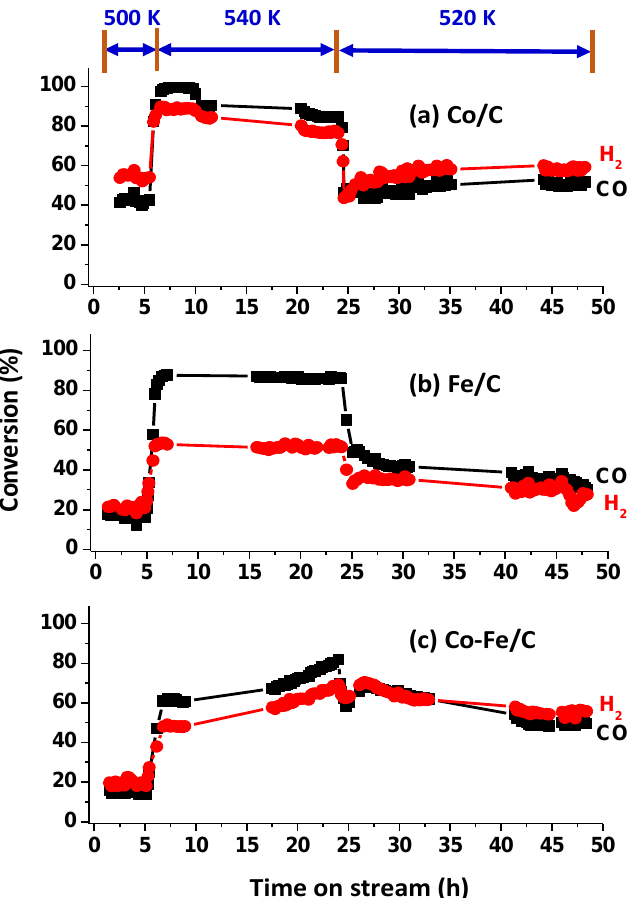
Figure 1. The activity of ( a ) Co/C, ( b ) Fe/C, and ( c ) Co-Fe/C catalysts tested at 500 K, 520 K, and 540 K (pressure = 2 MPa; GHSV = 2000 cm 3 h − 1 g − 1 of the catalyst) indicating the CO and H 2